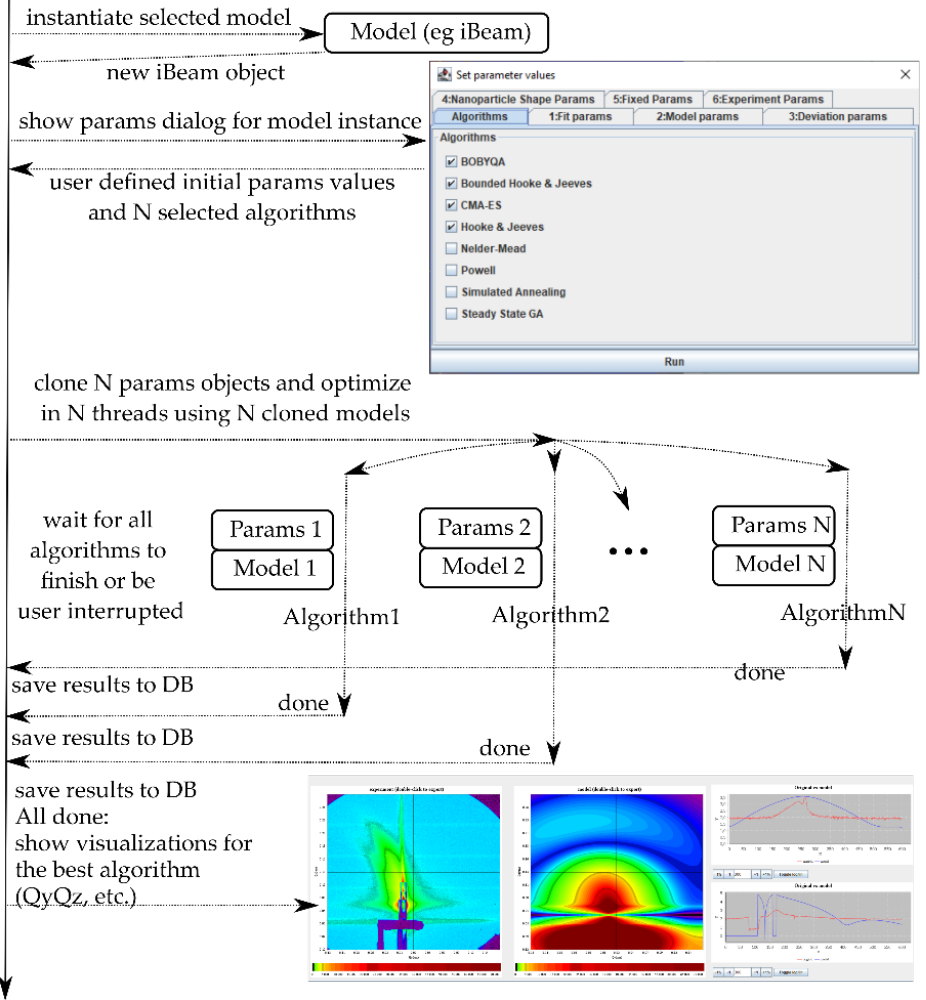
Figure 2. Fitting procedure in GisaxStudio: after the user selects the model and assigns initial values of the corresponding model, the application spawns N threads (corresponding to the number of chosen optimization algorithms) and initiates a multi-threaded optimization. When all the threads are finished (or interrupted by the user), the application visualizes the resulting winning algorithms.